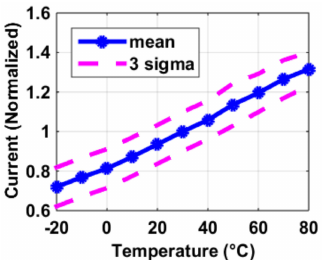
Figure 10. Extracted current level and temperature dependency in a constant g m biasing circuit using the measurement results of the SF’s g m , SF in Figures 6 and 9.